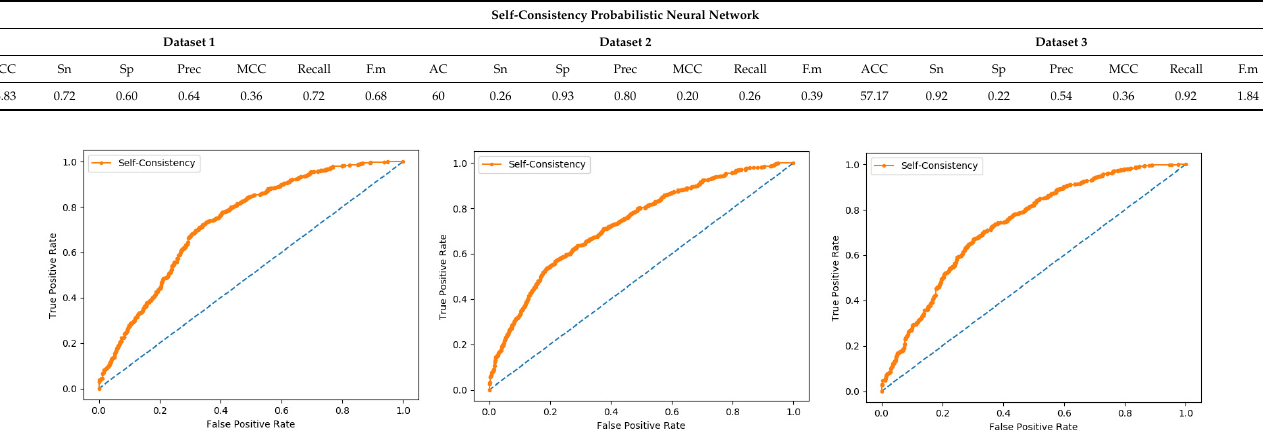
Figure 11. Self- consistency Probabilistic Neural Network ROC curve.